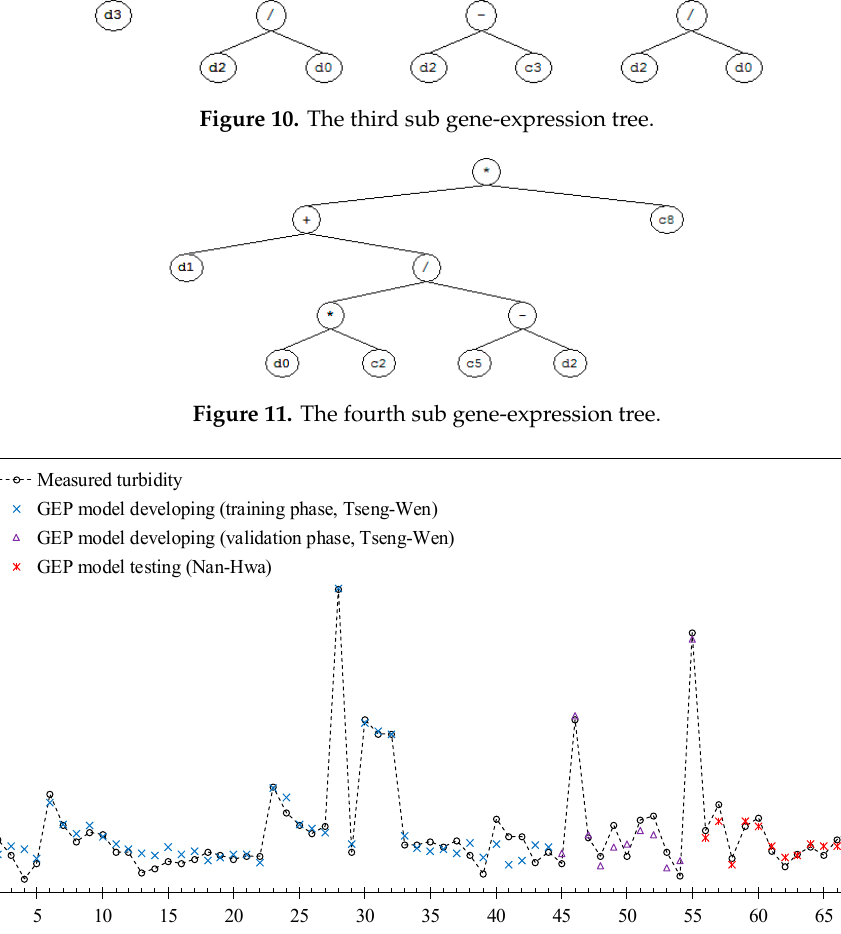
Figure 13. The correlation relationship of observed turbidity and the turbidity simulated by the gene- expression programming (GEP) model in Tseng-Wen and Nan-Hwa reservoir. 𝐺𝐸𝑃 = 𝐸𝑇 (cid:3046)(cid:3048)(cid:3029)(cid:2869) × 𝐸𝑇 (cid:3046)(cid:3048)(cid:3029)(cid:2870) × 𝐸𝑇 (cid:3046)(cid:3048)(cid:3029)(cid:2871) × 𝐸𝑇 (cid:3046)(cid:3048)(cid:3029)(cid:2872)